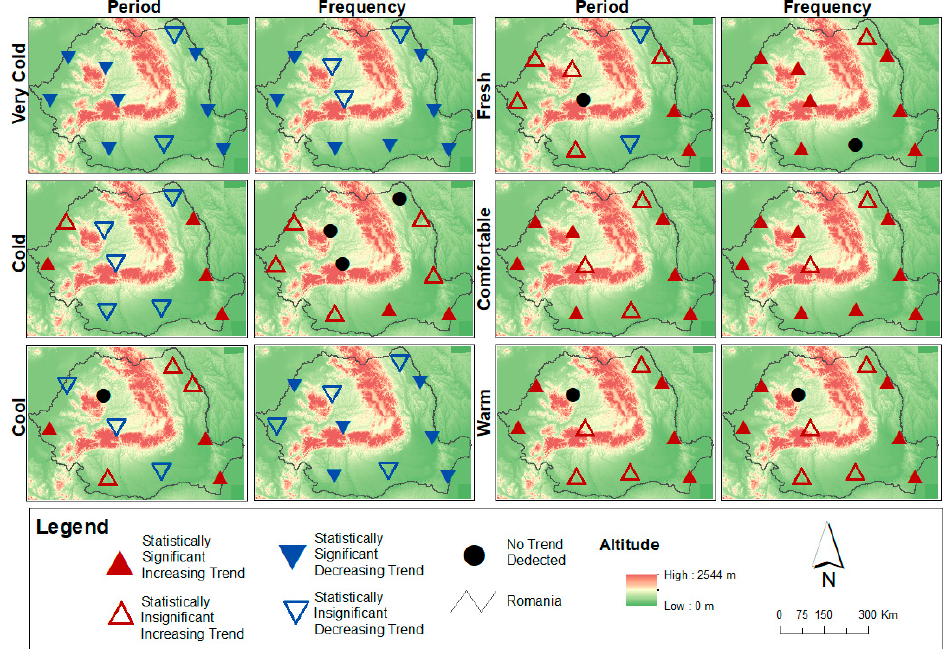
Figure 7. Spatial distribution of the trends detected for the TE index.